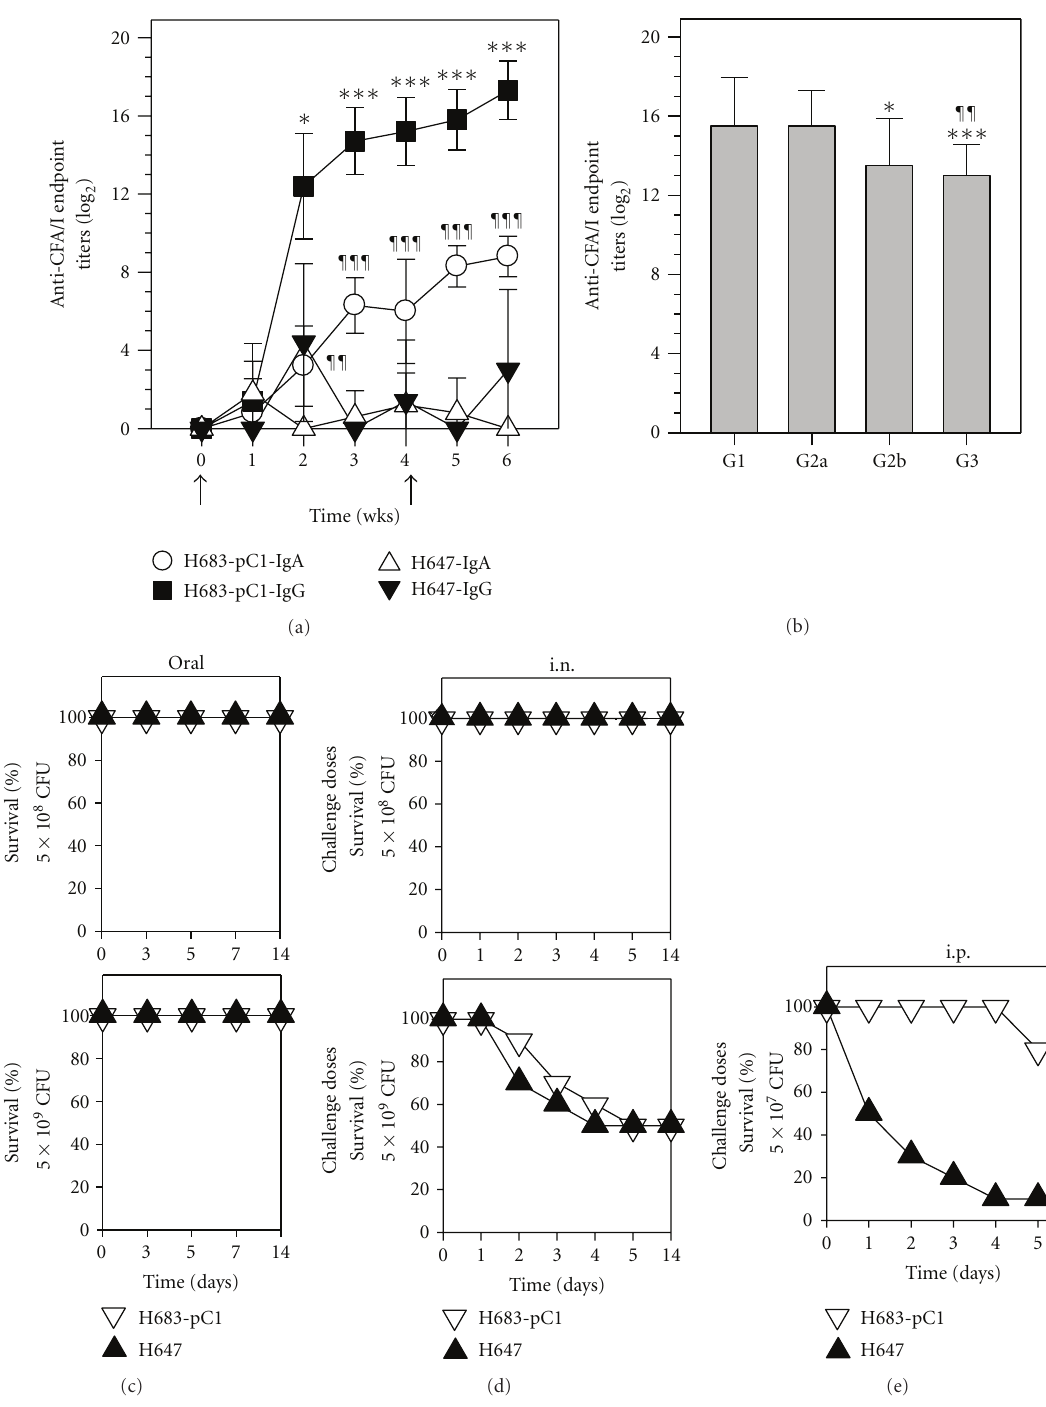
Figure 3: Salmonella vaccine H683-pC1 stimulates elevated anti-CFA/I fimbriae Ab titers and protects against i.p. ETEC challenge. (a) BALB/c mice (5/group) were orally immunized twice on days 0 and 28 with 5 × 10 9 CFUs of S. typhimurium H683-pC1 and H647, respectively. Elevated serum IgG and mucosal IgA anti-CFA/I fimbriae Ab responses were induced. Depicted are the mean ± SEM from two independent experiments. (b) At wk 6, serum IgG subclass analysis was performed, and statistical di ff erences in the endpoint Ab titers were determined. ∗ P < 0 . 05, ∗∗ P < 0 . 01, ∗∗∗ P < 0 . 001 versus IgG1; ¶¶ P < 0 . 01 versus IgG2a. (c)–(e) Comparison of di ff erent routes of challenges with wt ETEC H10407 among CFA/I fimbriae-immunized BALB/c mice. At 6-wk postprimary immunization, mice were challenged with wt ETEC H10407 (c) orally with 5 × 10 8 or 5 × 10 9 CFUs, (d) i.n. with 5 × 10 8 or 5 × 10 9 CFUs, or (e) i.p. with 5 × 10 7 CFUs. Mice survival was monitored for two wks. Results are from two independent experiments; survival fractions obtained from vaccinated mice were compared to H647-immunized mice, and significance was determined; ∗ P < 0 .